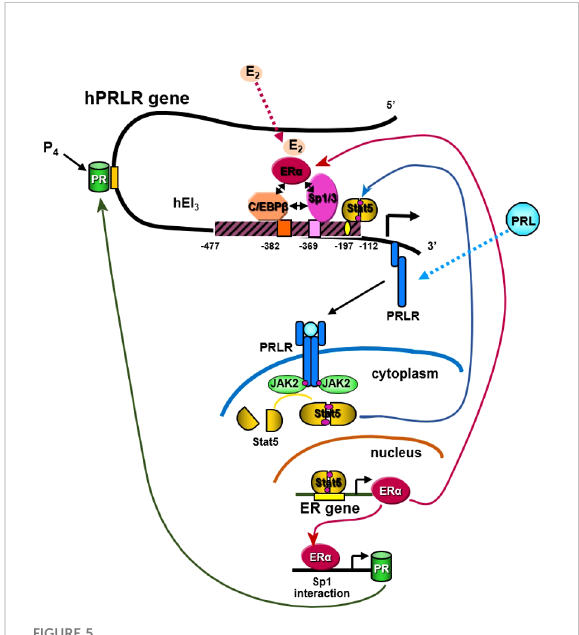
FIGURE 5 Transcriptional regulation of hPRLR induced by E2. E2 induces ligand mediated ER a -Sp1-C/EBP b complex formation and binding to the hPIII promoter of the hPRLR gene (38, 39). This results in increased transcription of PRLR. PRL/PRLR activates JAK/STAT that can induce the transcription of ER a . P4 (progesterone)/Prog receptor can induce transcription of PRLR through association with Sp1and C/EBP b through promoter